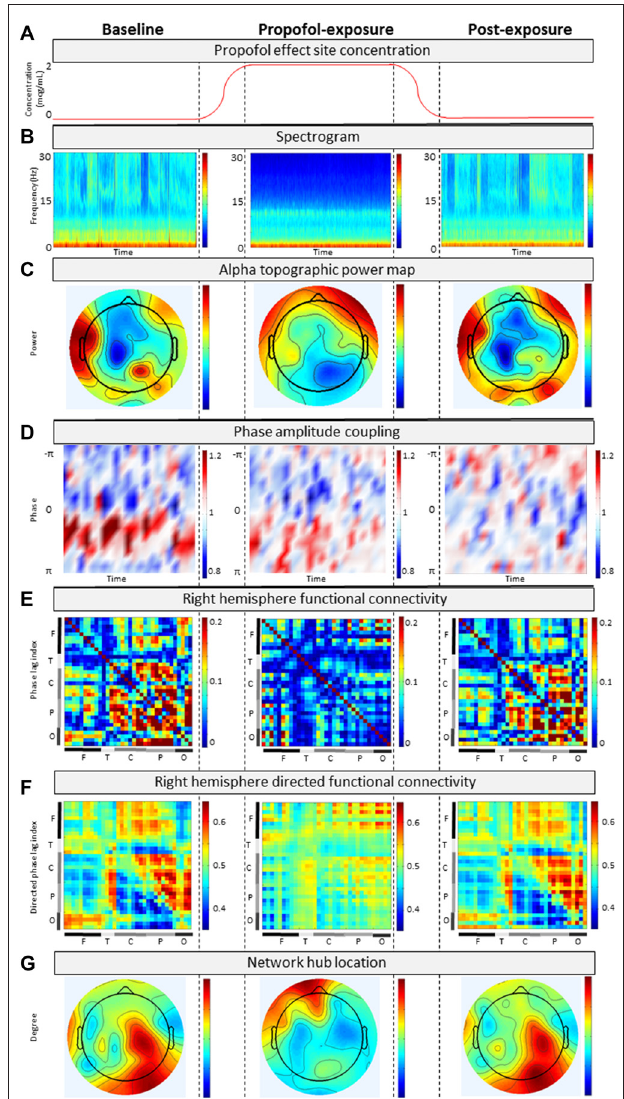
FIGURE 3 | Analysis of continuous electroencephalograph (EEG) for (A) baseline, propofol-exposure and post-exposure periods using (B) spectrogram; (C) alpha topographic power map; (D) phase-amplitude coupling; (E) phase lag index; (F) directed phase lag index; and (G) network hub